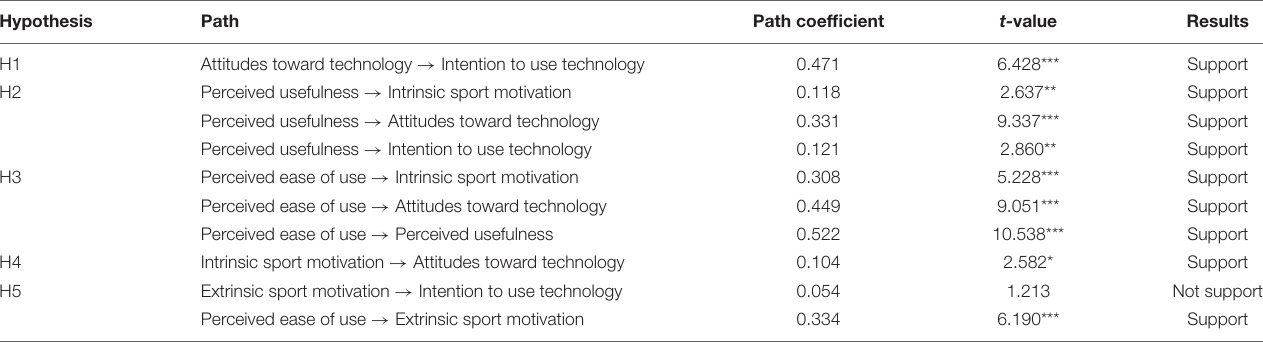
TABLE 3 | Hypothesis testing.